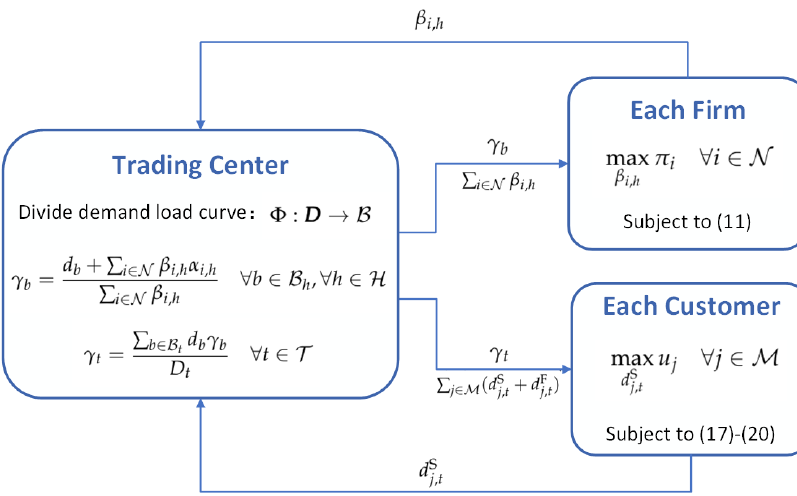
Figure 5. Block diagram of the proposed mathematical